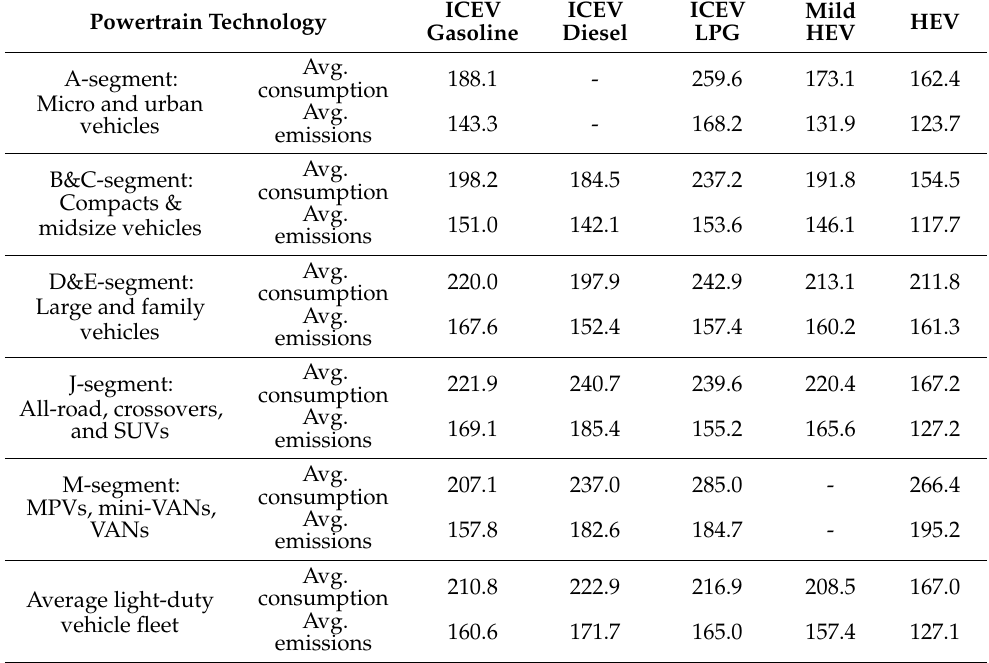
Table 5. The WtW results for the ICEV and hybrid